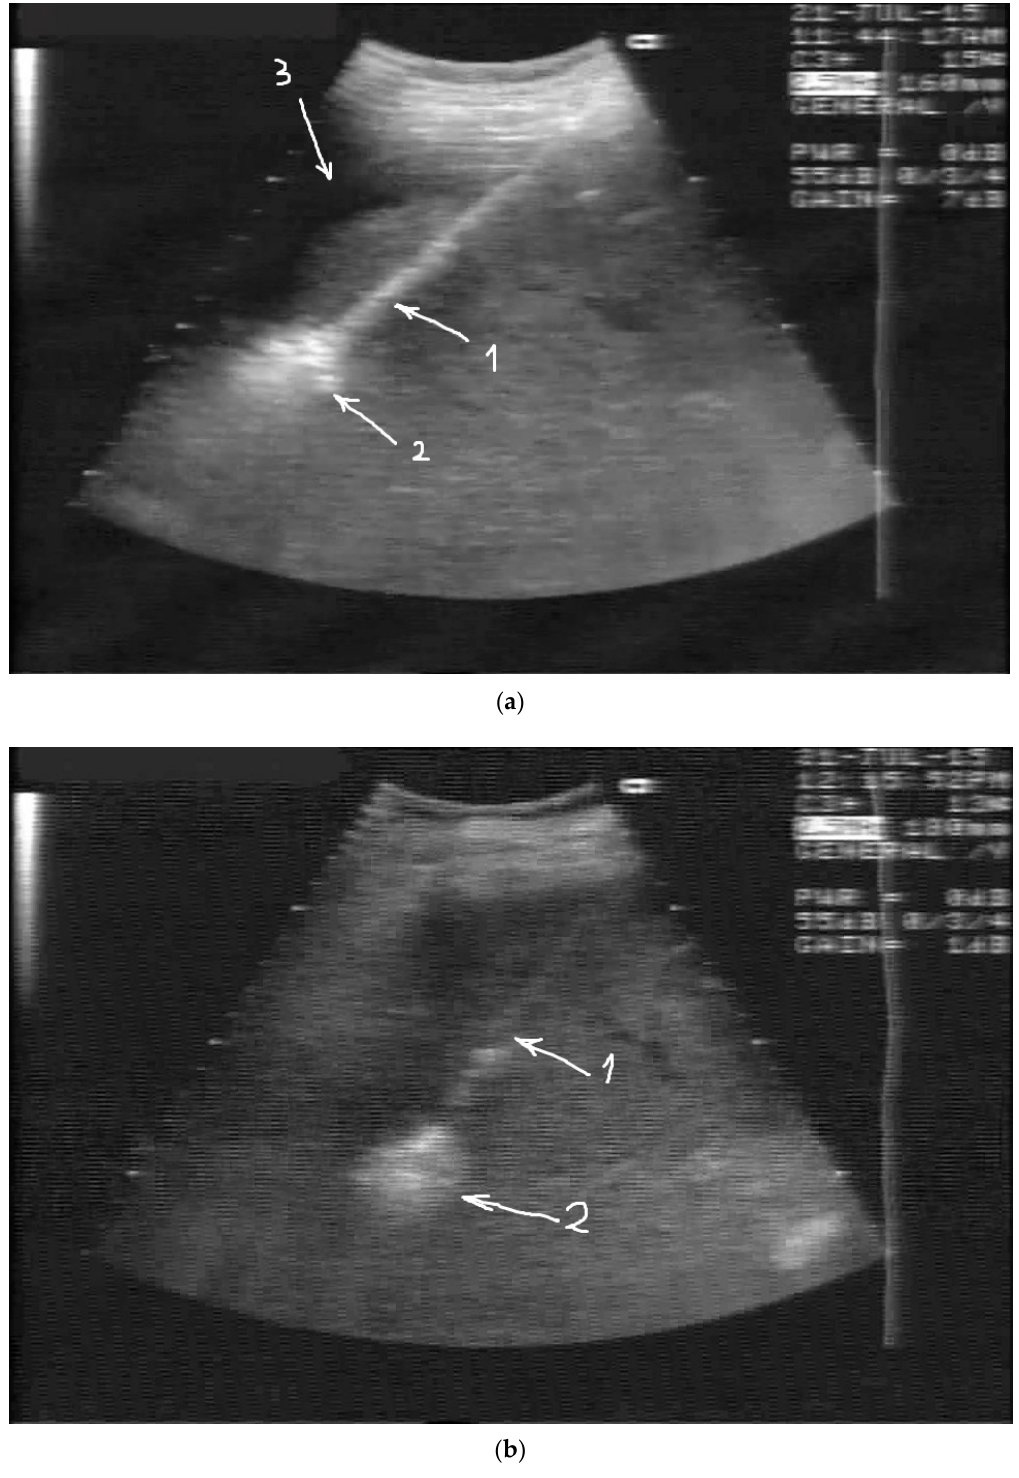
Figure 3. ( a ) US-guided RFA ablation of mass 1. 1—RFA electrode, 2—hyperechoic cloud showing the ablation process, 3—fluid in the peritoneal cavity, injected for hydrodissection. ( b ) US-guided RFA ablation of mass 2. 1—RFA electrode, 2—hyperechoic cloud showing the ablation process.